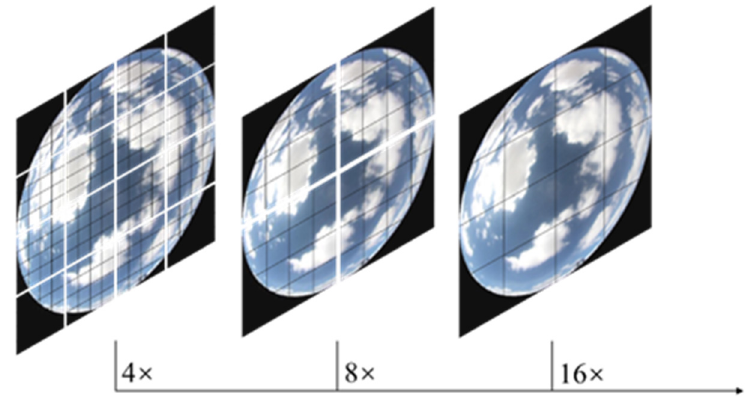
Figure 5. Illustration of hierarchical feature maps.